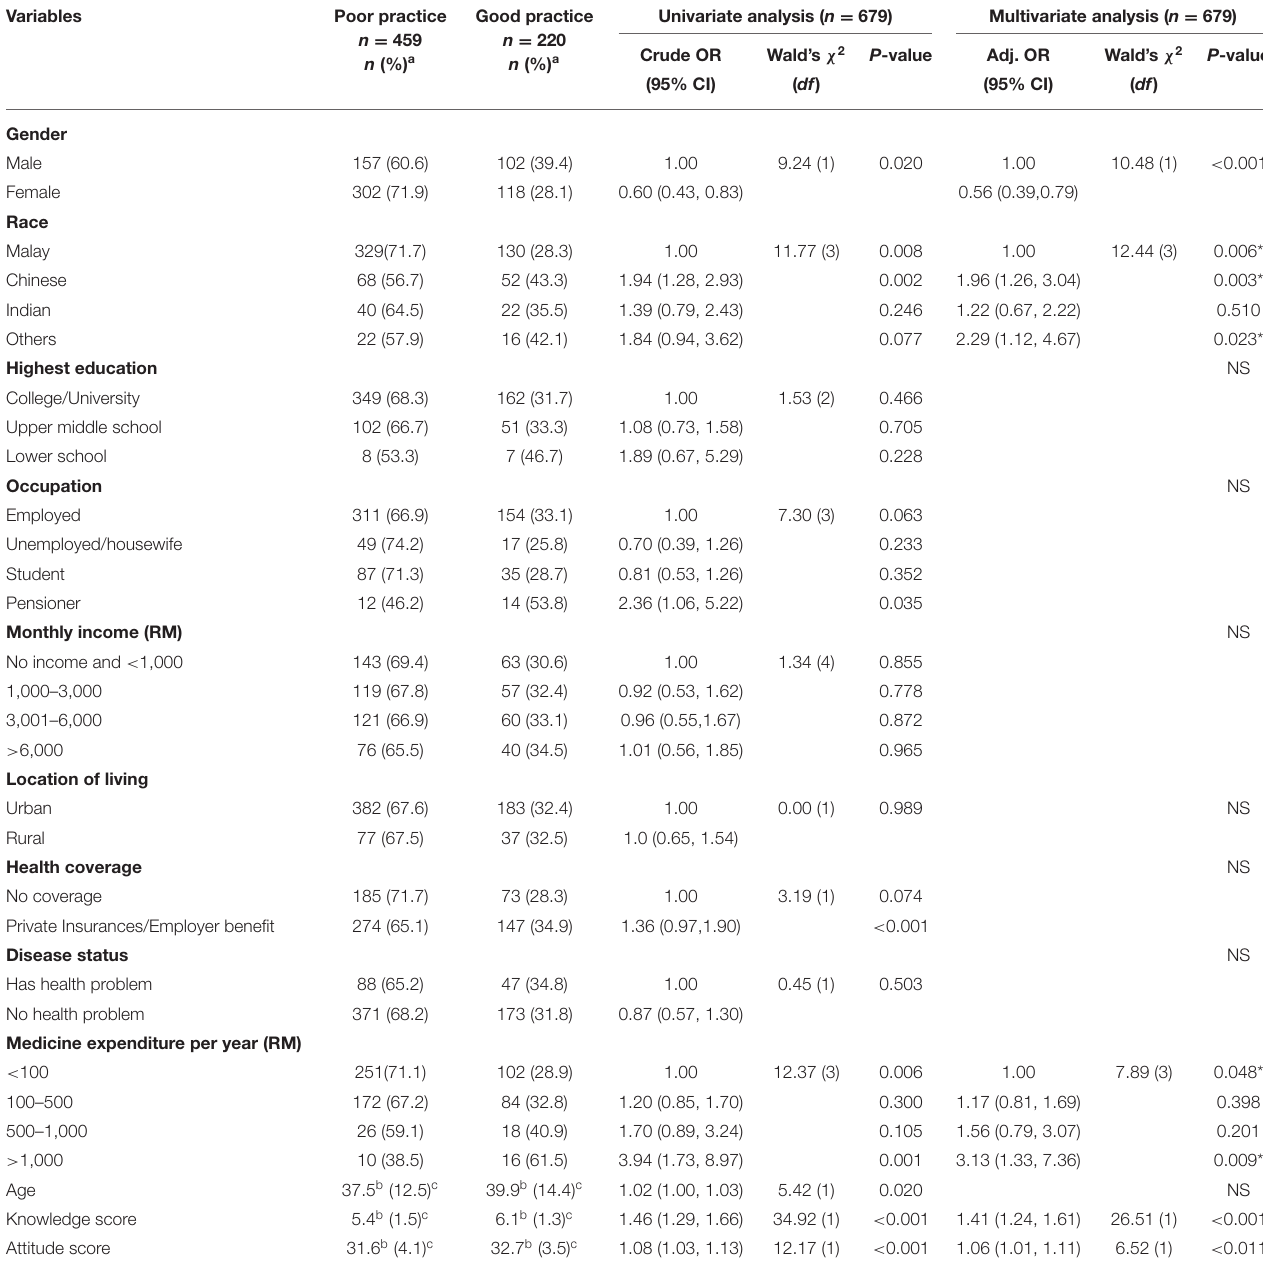
TABLE 5 | Factors that may influence respondents’ good practice toward medicine price transparency at the private healthcare